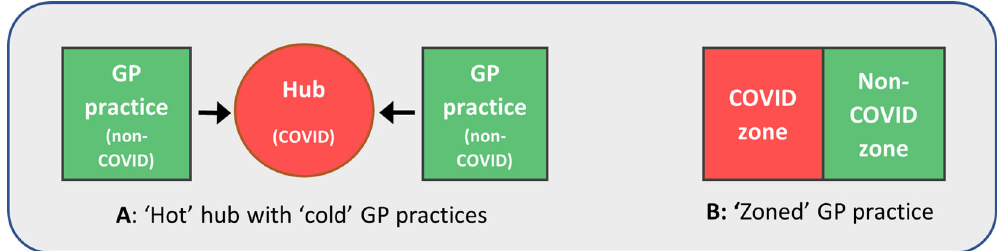
Figure 1. Typical models used to separate patients with suspected or diagnosed COVID-19 from others in general practice. Variations of these models could be used, as well as designated ‘ COVID-19 ’ and ‘ non-COVID-19 ’ home visiting